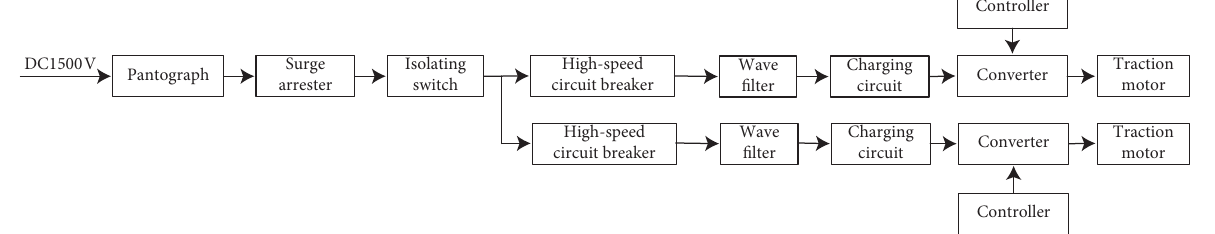
Figure 2: Circuit diagram of the MTS.